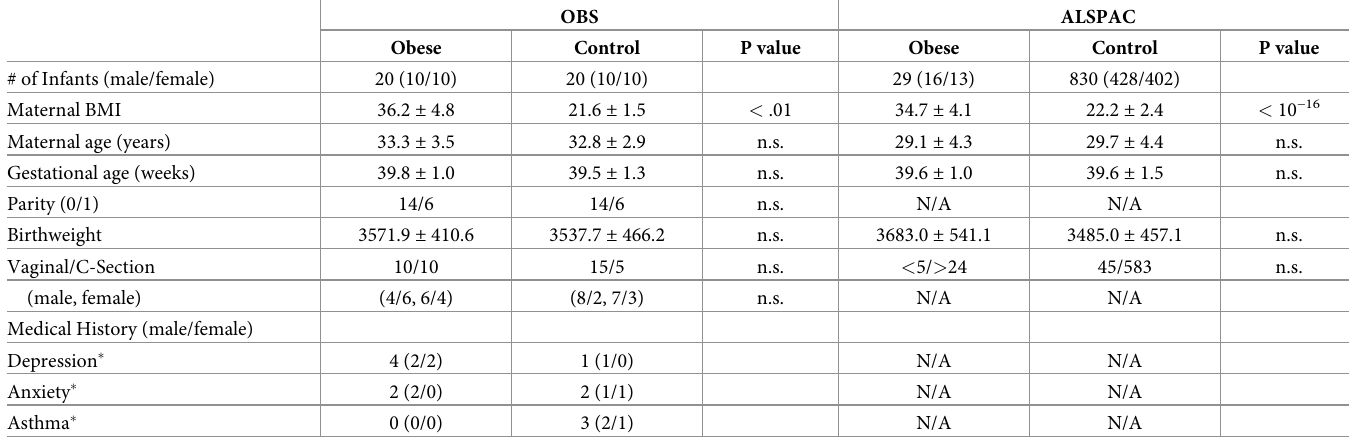
RRBS involves restriction enzyme digestion to enrich for areas of the genome with a high CpG content, whereas in 450K arrays, the coverage per gene has a wide range from one to over 1000 CpG sites [50]. As a result, different R packages optimized for identifying DMRs were used following RRBS and array analysis. Preprocessing, filtering of low quality probes, and normalization of 450K Illumina microarray data were performed using the minfi package, ver- sion 1.40.0 [51]. DMRs associated with maternal BMI were investigated using the R package Table 1. OBS and ALSPAC subject demographics. OBS ALSPAC Obese Control P